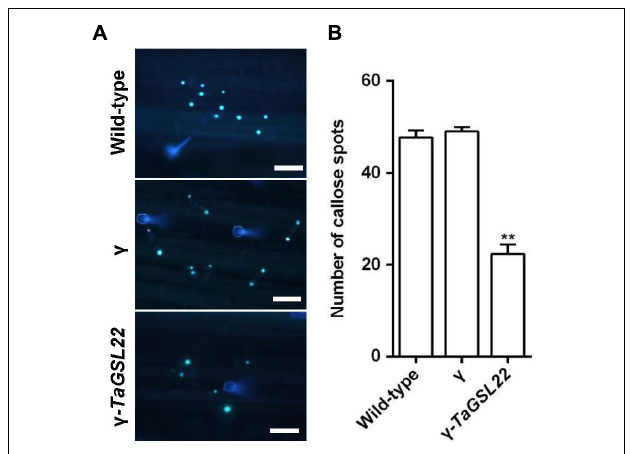
FIGURE 7 | Down-regulation of TaGSL22 expression reduced the callose deposition in host plant. (A) Representative wheat leaves stained with aniline blue for callose deposition (bar = 100 µ m). Pictures of control plants (wild-type and γ ) and the gene-silenced plants ( γ - TaGSL22 ) were taken at 24 hpi with Bgt avirulent race E09 at × 10 magnification with an Olympus BX-51 microscope. (B) The average number of callose foci per field of view (1 mm 2 ) was calculated from 30 fields for each sample. Error bars represent SEM of three biological replicates. ** represent significant differences at P < 0.01 (Student’s t